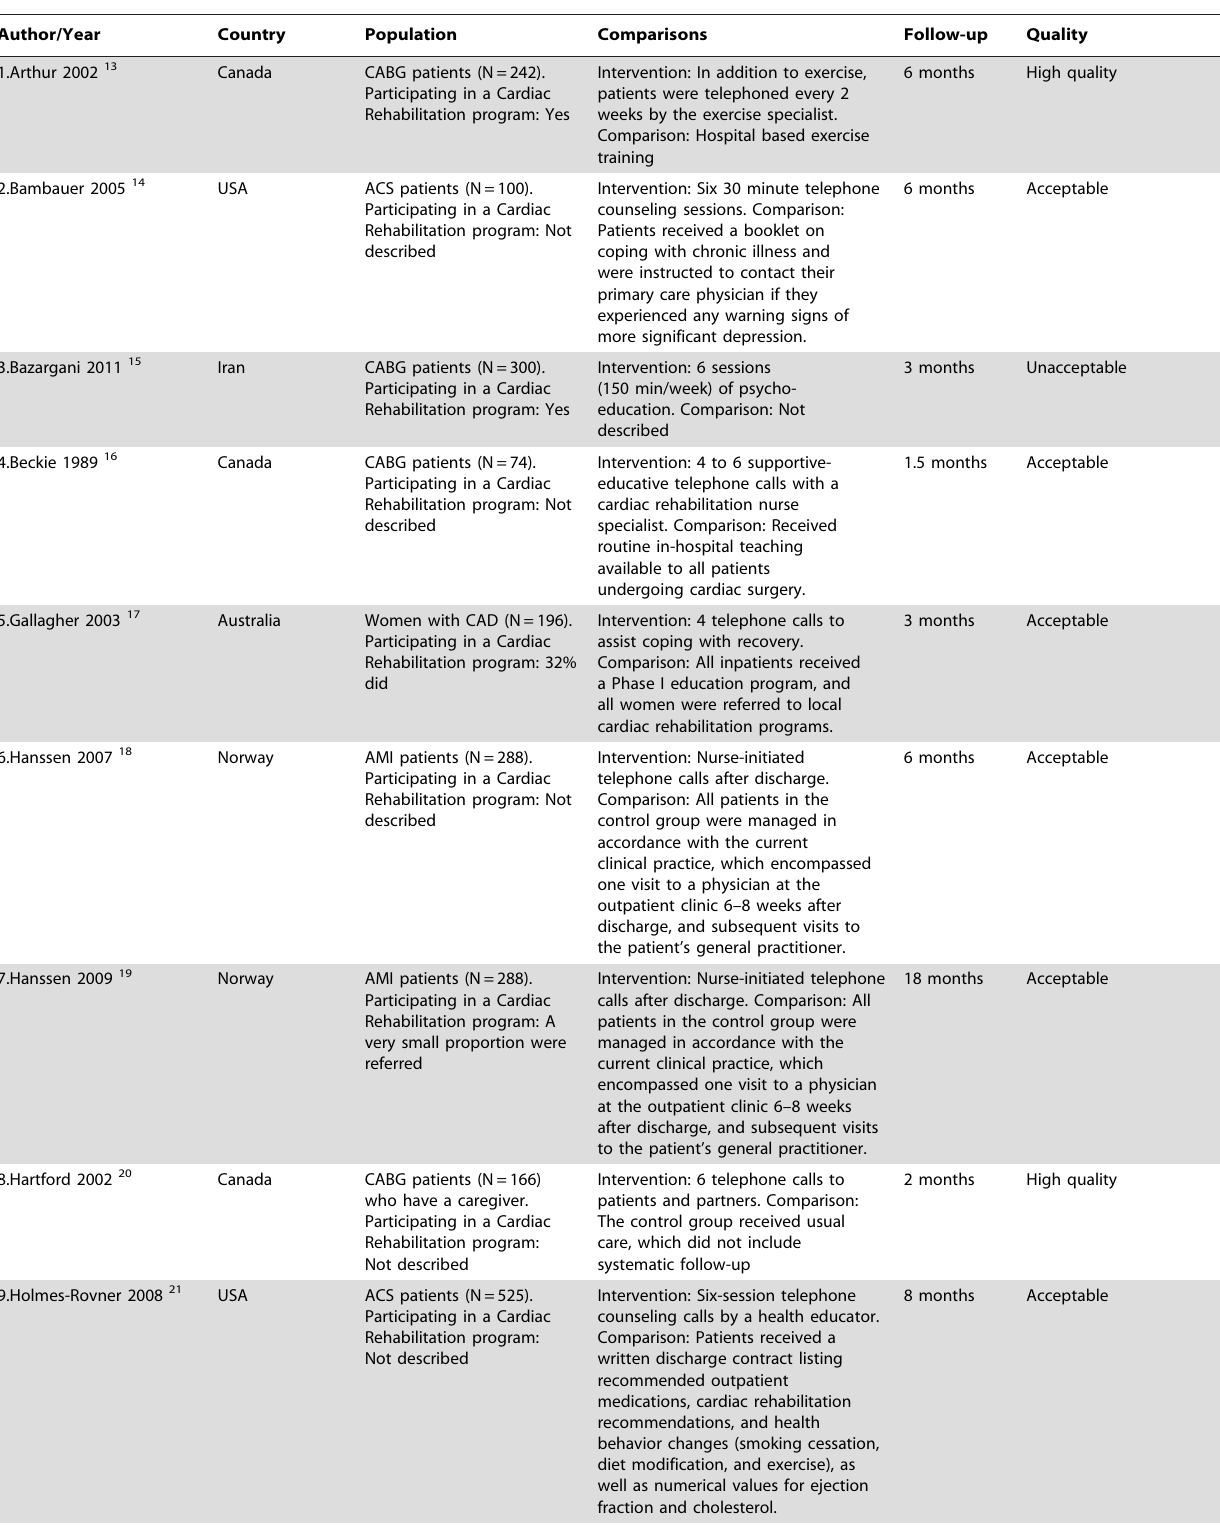
Table 1. Characteristics of included